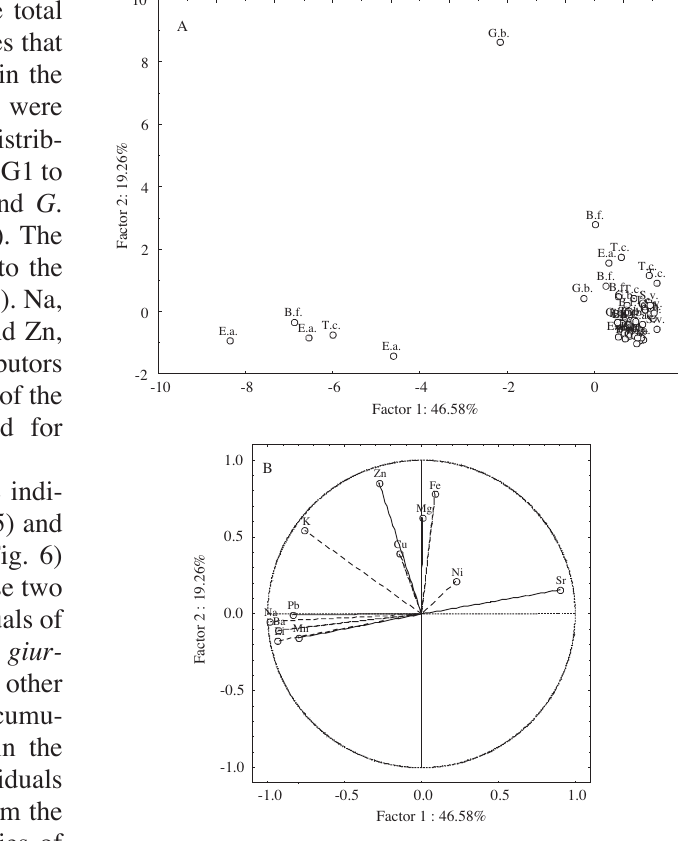
F IG . 6. – The result of PCA grouping of 53 individuals of the 5 species of non-amphidromous estuarine larval gobies (A) classified by the relative contribution of the otolith element/Ca ratios in the first two components of PCA (B). See Table 2 for species